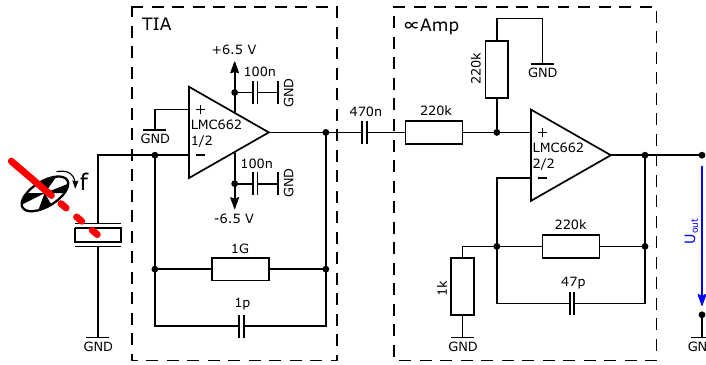
Figure 3. A scheme of the readout circuit for the pyroelectric detector. The modulated radiation that hits the pyroelectric detector leads to a generation of free